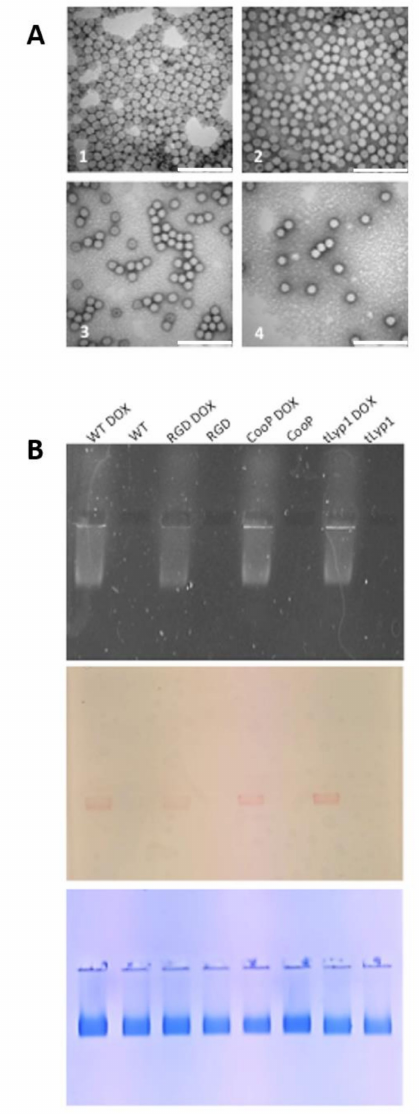
Figure 5. TBSV NPs transmission electron microscopy and DOX loaded TBSV NPs native agarose gel electrophoresis. ( A ) Visualization by negative staining and high-resolution transmission electron microscopy of purified TBSV NPs. (1): TBSV-WT NPs; (2): TBSV-RGD NPs; (3): TBSV-tLyp1 NPs; (4): TBSV-CooP NPs. Bar scale: 200 nm. ( B ) Native agarose gel visualized under UV light (upper panel), and white light before (middle panel) and after Coomassie blue staining (lower panel). Four µ g of NPs were loaded in each well. TBSV NPs, loaded or not with DOX, are indicated for each